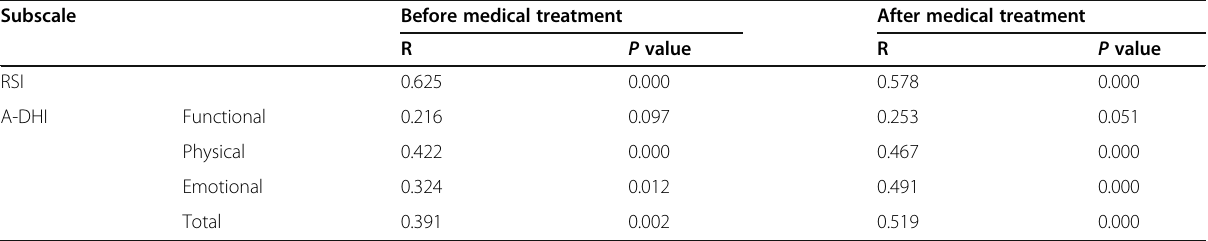
Table 6 Correlation between overall severity of swallowing and RSI/A-DHI before and after treatment Subscale Before medical treatment After medical